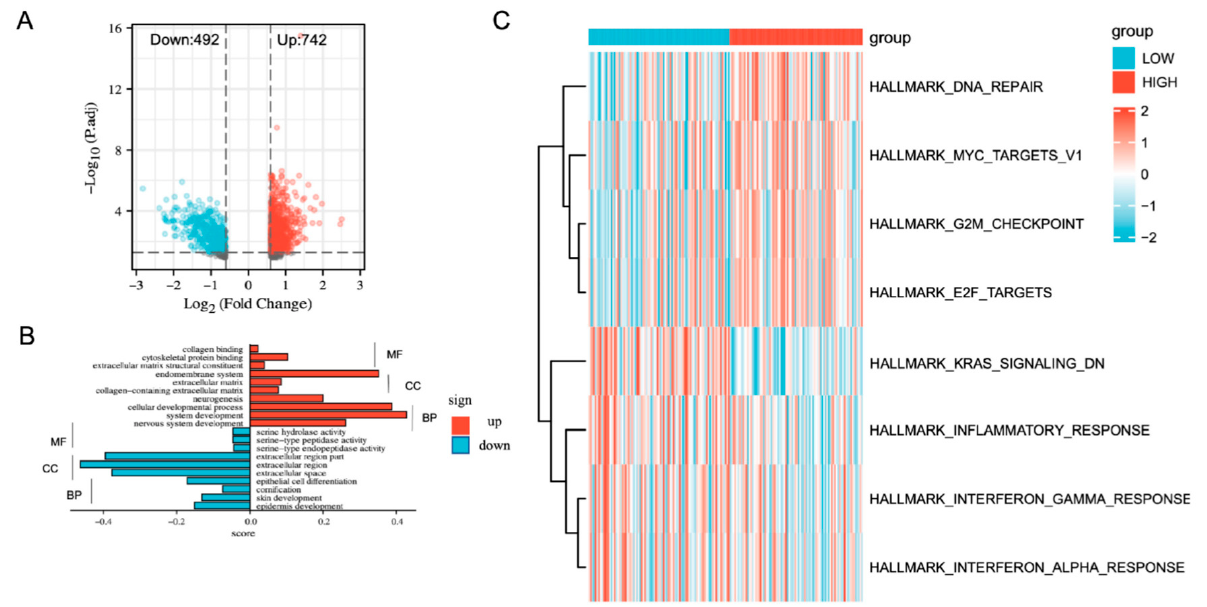
Figure 3. Identification of biological pathways associated with the risk of erlotinib resistance. ( A ) DEGs between the resistance score groups. ( B ) GO analysis of DEGs between the resistance score groups categorized into three functional groups: BP, CC, and MF. ( C ) GSVA of the resistance score groups. BP: biological process; CC: cellular component; MF: molecular function. Red represents upregulated genes, blue represents downregulated genes.